Question: Describe this figure in one sentence.
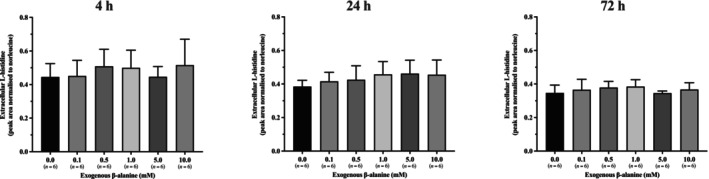
Answer: Extracellular L‐histidine in the incubation medium of differentiated H9c2 cells after 4, 24, and 72 h of exogenous β‐alanine incubation. Data are calculated as analyte peak area normalized to the internal standard (Norleucine) peak area and presented as mean ± 1 SD. Replicate numbers included in analysis are presented underneath each respective concentration.